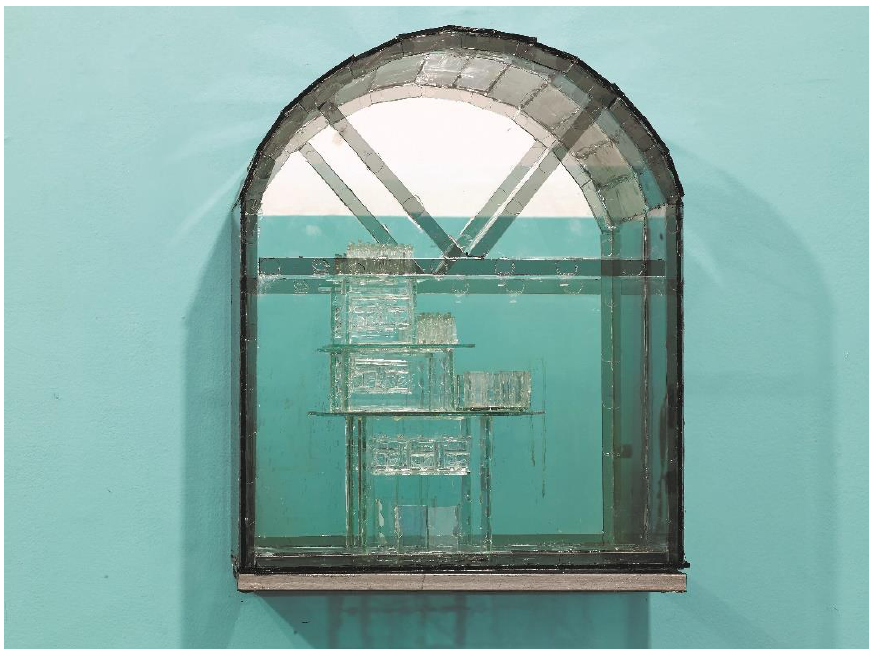
Figure 5. Alina Rom Cohen, 1400 km, 2019